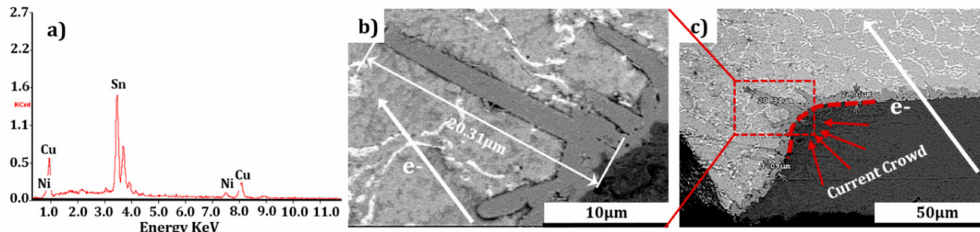
Figure 3. Energy spectrum and SEM images of the rapid growth of (Cu x ,Ni 1 − x ) 6 Sn 5 IMC at the cathode end in the SnPb (Pb content is 22.46%) microbump after stressing at the current density of 2.5 × 10 3 A / cm 2 for 100 hr at CT ( − 196 ◦ C). ( a ) is EDS image; ( b ) is Partial image; ( c ) is Panoramic